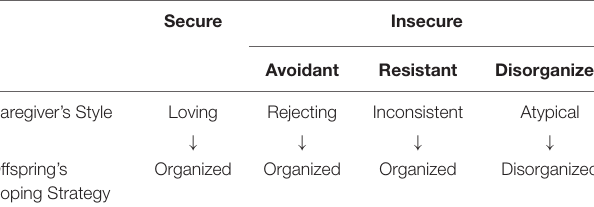
TABLE 1 | Attachment styles and their